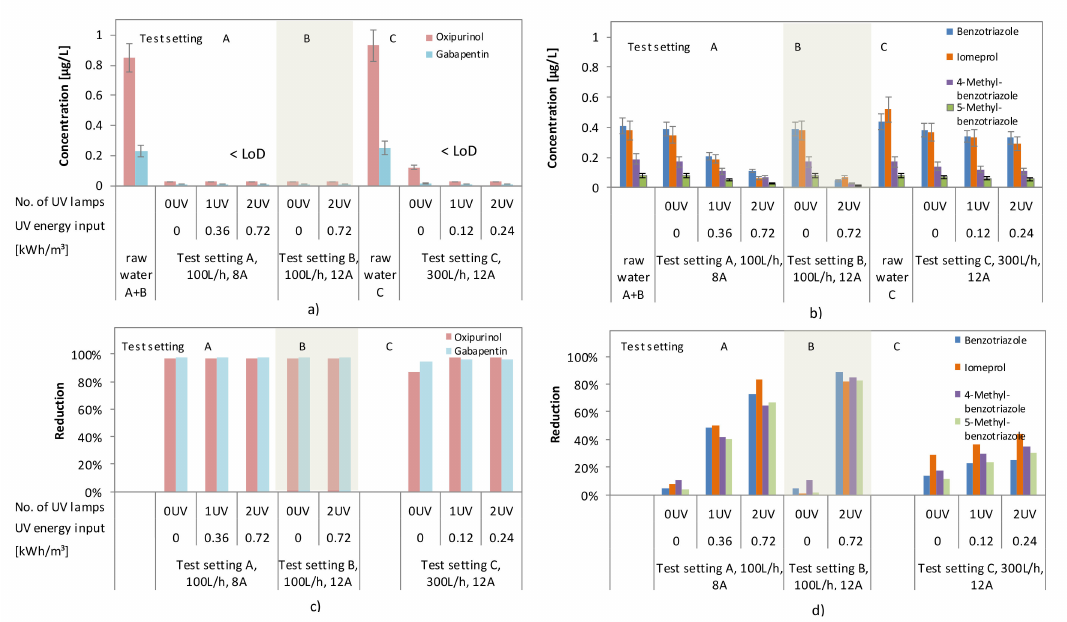
Figure 10. Concentrations of tested TOrCs ( a , b ) and degradation percentages ( c , d ) concentrations measured in three di ff erent settings during field tests with Elbe river